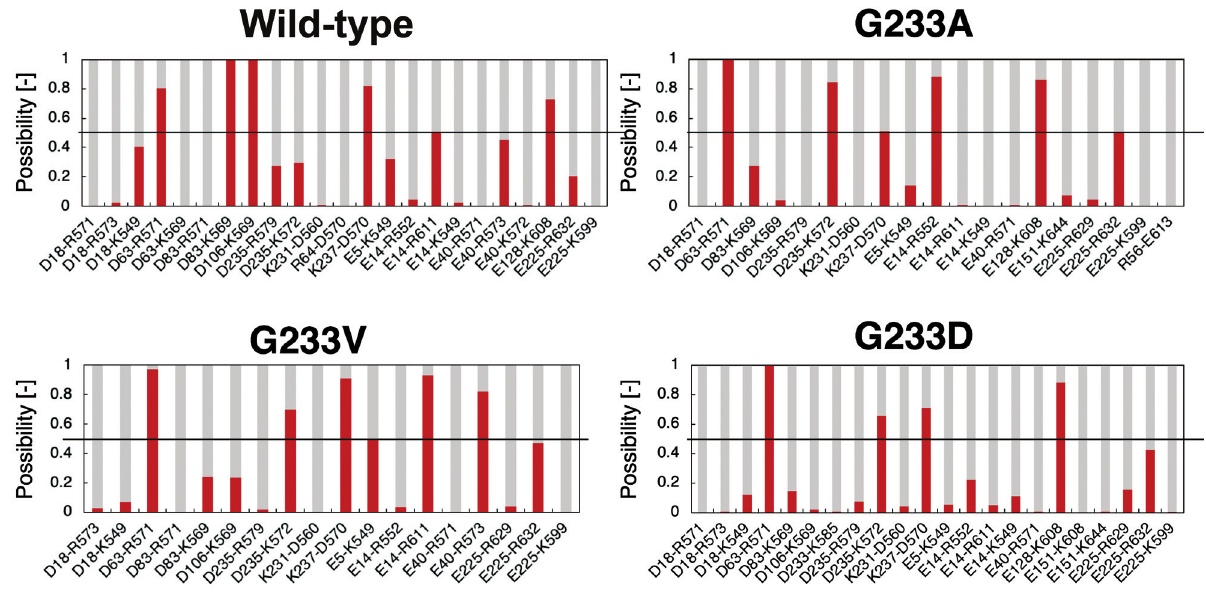
Fig. 4 Probability of the presence of salt bridges formed between VWF and GPIba. The probabilities of salt bridge formation for the pairs of amino acids in GPIb ɑ -VWF shown at the bottom of each panel are shown in red bar. The upper left panel shows the results of VWF binding with wild-type GPIb ɑ . The upper right, lower left, and lower right panel show the results of VWF binding with G233A, G233V, and G233D mutants of GPIb ɑ , respectively. Thin black line in each panel shows the threshold of 50%.